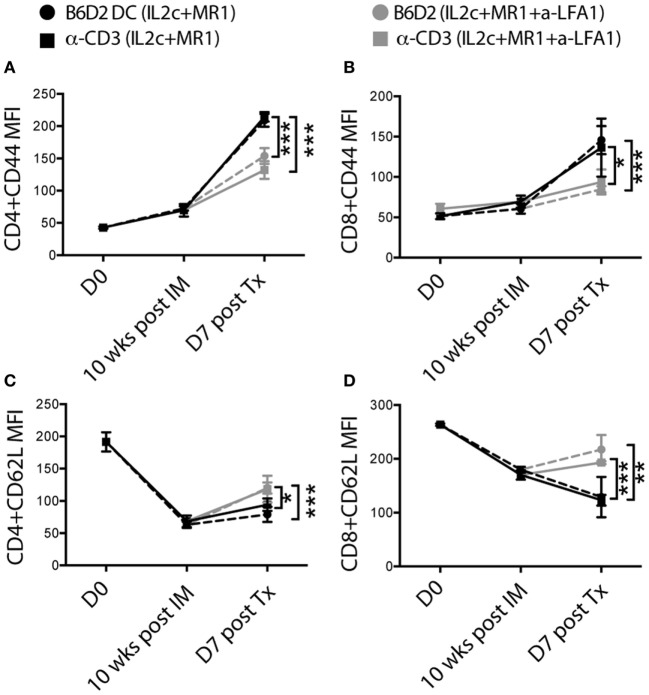
In pre-sensitized mice, addition of anti-LFA-1 to IL2c-MR1 therapy restricts the activation and effector function of alloreactive T cells in response to an allograft. B6 mice were tail-bled at day 0, 10 weeks post immunization (with B6D2 DC or anti-CD3), which corresponded to the day of transplantation and at day 7 post B6D2 allograft for flow cytometry analysis. (A–D) Changes in mean fluorescence intensity of CD44 and CD62L expression on peripheral CD4+ and CD8+ T cells. n = 4–6 mice/group (*P < 0.05, **P < 0.01, and ***P < 0.001).